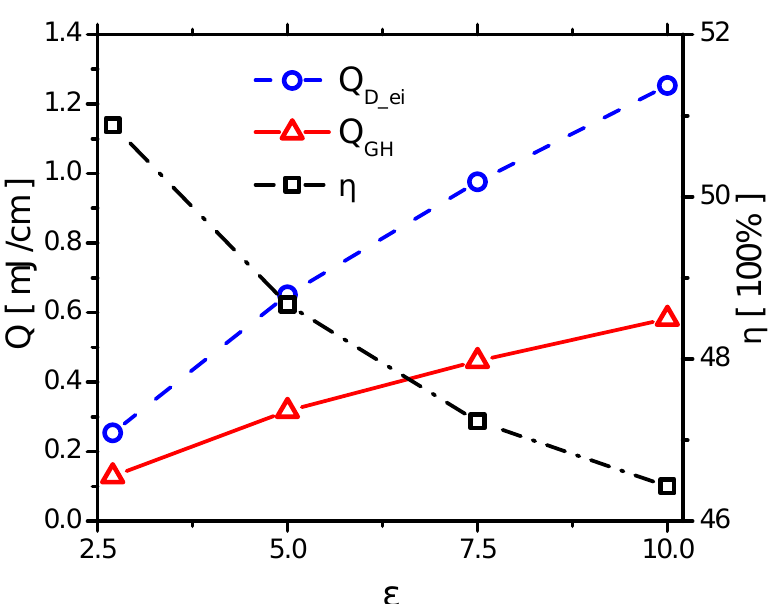
Figure 21. The effects of ε on the discharge energy Q D _ ei , the gas heating Q GH and its efficiency η GH in Case 1 to Case 4.